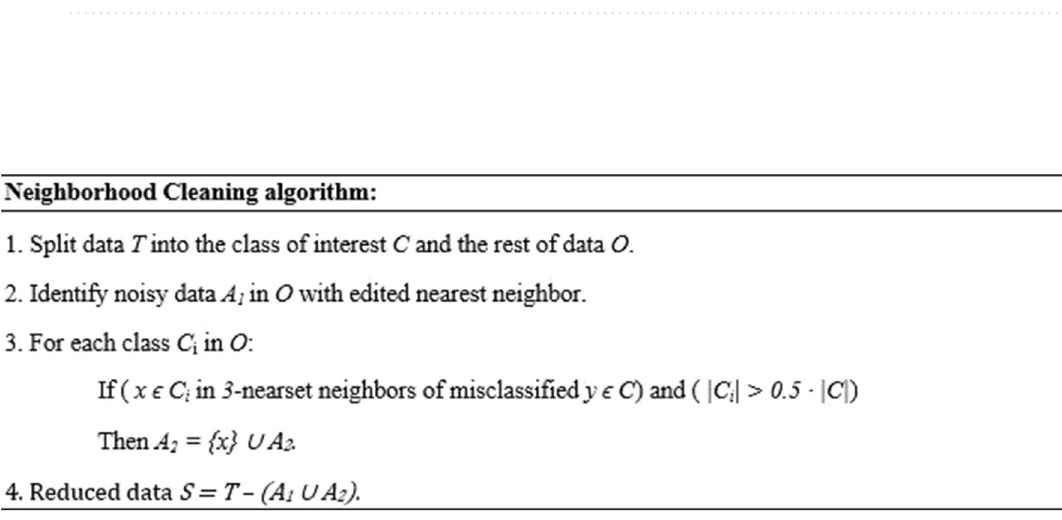
Figure 6. Flowchart of performed methodology to find the best dataset and predictor for potential aptamer-protein prediction. Where feature group 1 contained k-mer (k = 3) frequency for aptamers and 24 physicochemical and conformational properties of proteins sequences; group 2 involved k-mer (k = 4) frequency for aptamers and 24 physicochemical and conformational properties of proteins sequences, group 3 comprised Revckmer (k = 3) frequency for aptamers and 24 physicochemical and conformational properties of proteins sequences and group 4 included Revckmer (k = 4) frequency for aptamers and 24 physicochemical and conformational properties of proteins sequences. NCL neighborhood cleaning, MLP multi-layer perceptron, CNN convolutional neural network, KNN k nearest neighbor, SNN neural network, SVM support vector machine and RF random forest. The figure is drawn by using of Microsoft PowerPoint 2016 that is available in https ://www.offic e.com/.